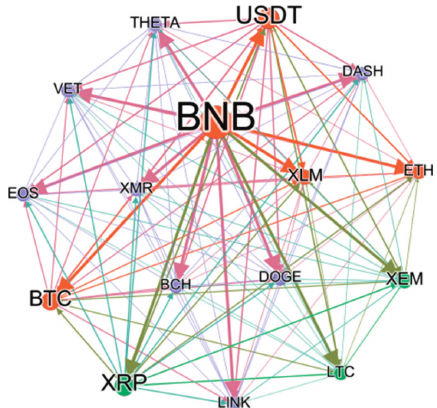
Figure 45: Risk spillover under R6.